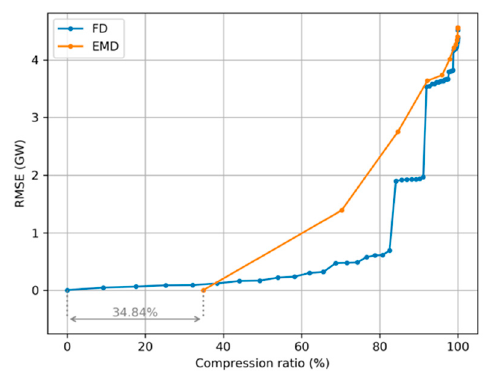
Figure 26. Spectral representation of electricity demand. Root Mean Square Error (RMSE) versus the percentage of discarded values (compression ratio) for Fourier Decomposition (FD) and Empirical Mode Decomposition (EMD). Table 1. Frequencies discovered for di ff erent spectral analysis methods.